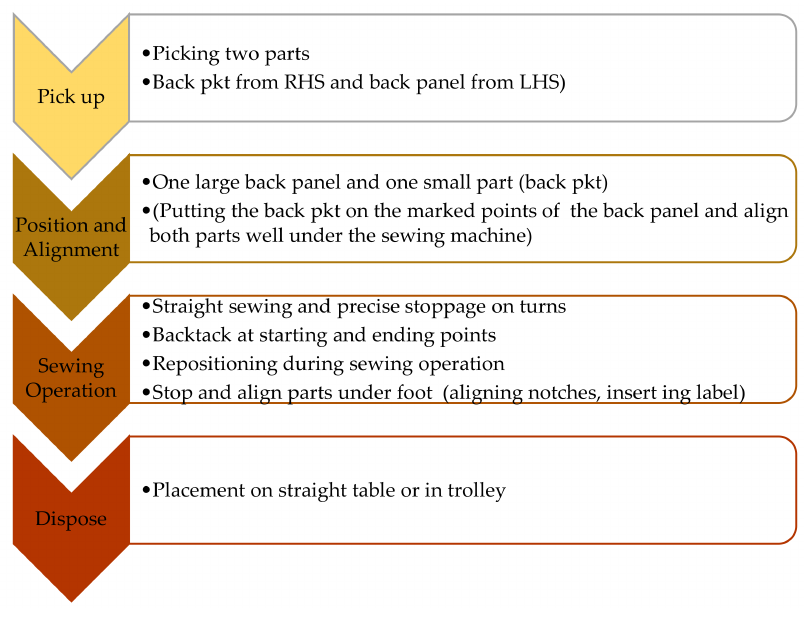
Figure 3. Sub tasks in the manual sewing